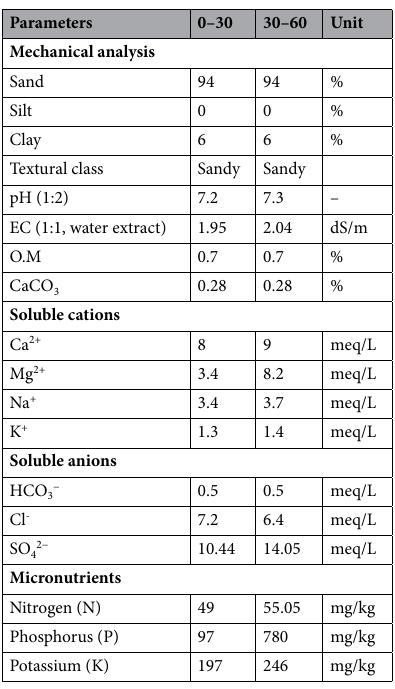
Table 1. Physiochemical analysis of the experimental